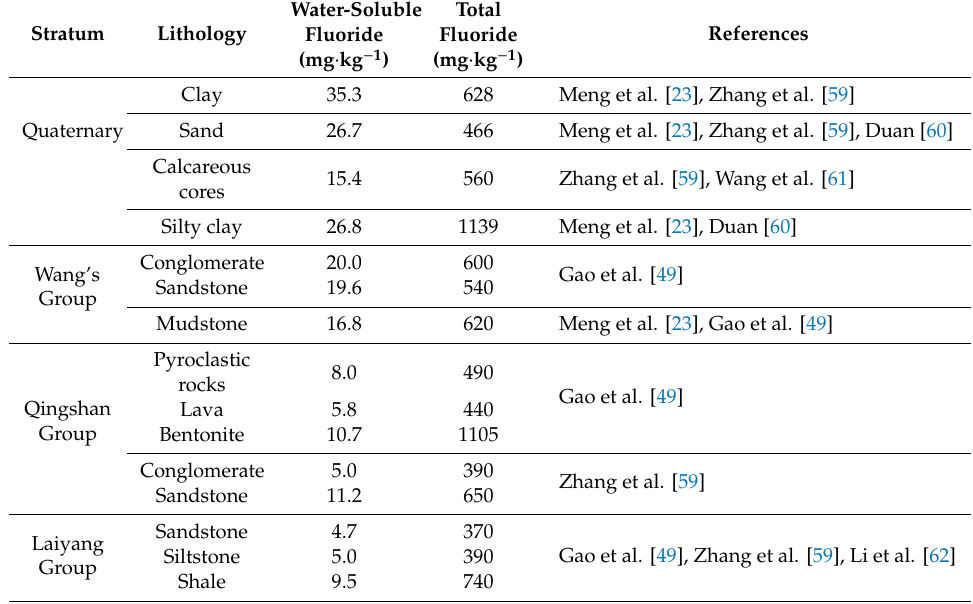
Table 3. Fluoride content of rocks and soils in the Jiaolai Basin, Jiaodong Peninsula, eastern China.